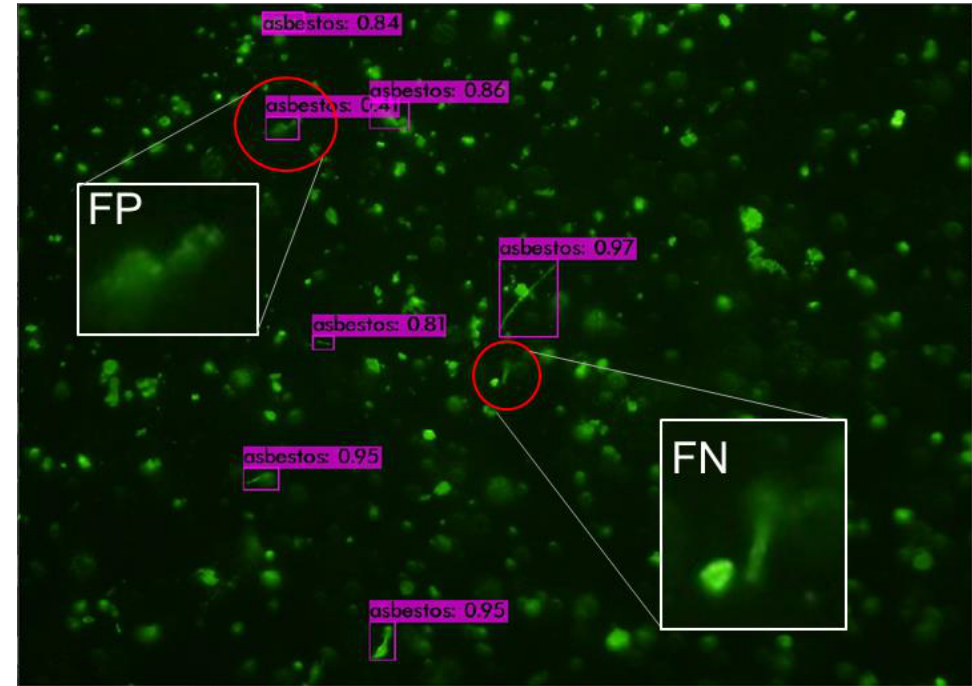
Figure 2. Evaluation metric change over threshold values.